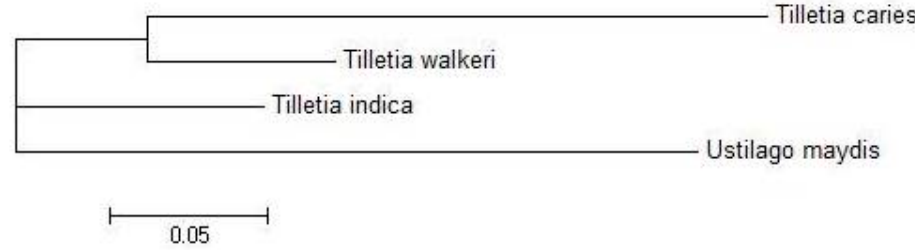
Figure 2. Molecular phylogenetic analysis of T. indica isolates using seven gene sequences.